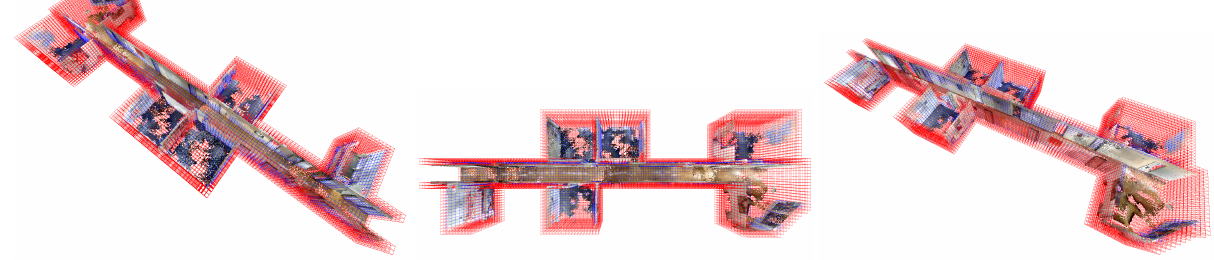
Figure 5. Experimental visualization results for point sparsity deviation analysis, with voxels containing below average number of points highlighted in red, and those that are healthy highlighted in